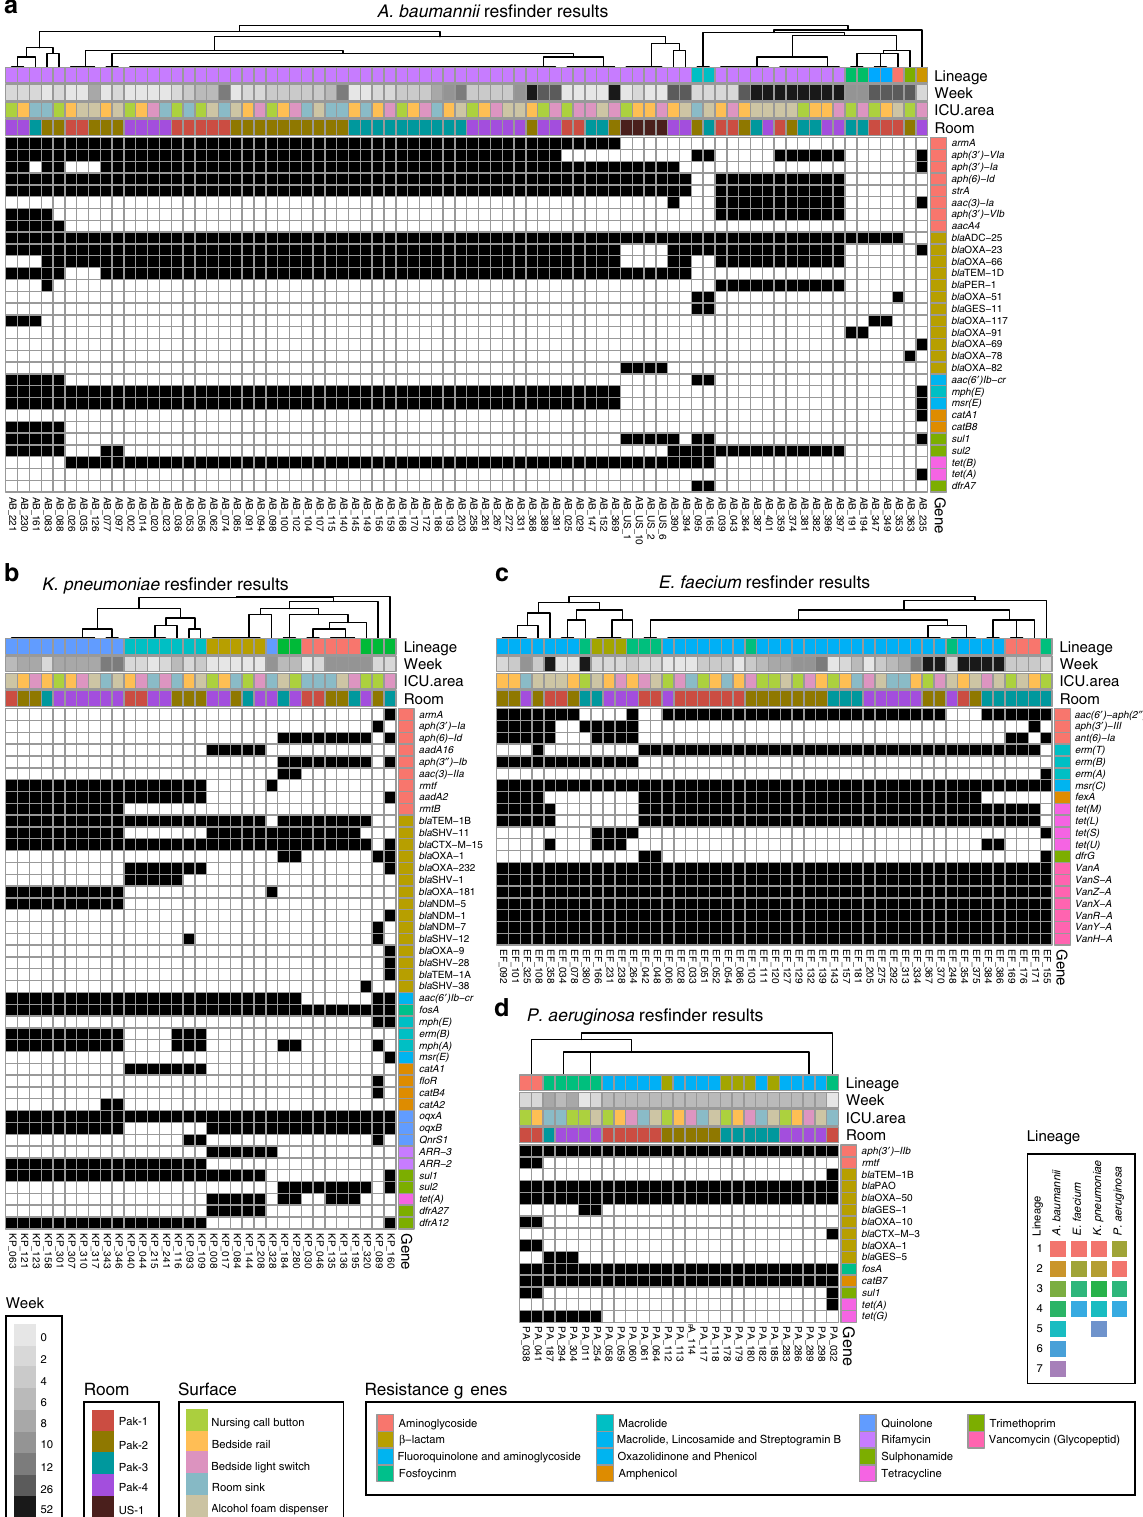
Fig. 7 Genotypic antibiotic resistance in major species. Res fi nder results for A. baumannii ( a ), K. pneumoniae ( b ), E. faecium ( c ), P. aeruginosa ( d ). Resistance genes are grouped by antibiotic class on the y -axis and individual isolates are hierarchically clustered by their resistance genes on the x -axis. Black squares indicate the presence of a speci fi c resistance gene in an isolate. Colored annotations are added next to the resistance genes for resistance gene class and above the charts for hierBAPS lineage (identi fi ed in Fig. 3 by branch color), week, surface, and room. Source data for all panels are provided in the source data fi